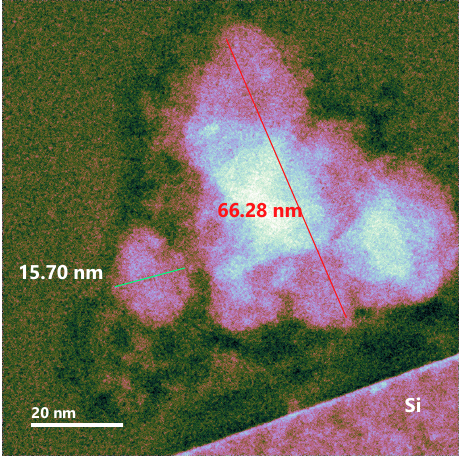
Figure 13. High Resolution Transmition Electronic Microscopy micrograph of the A1 SiO x film.